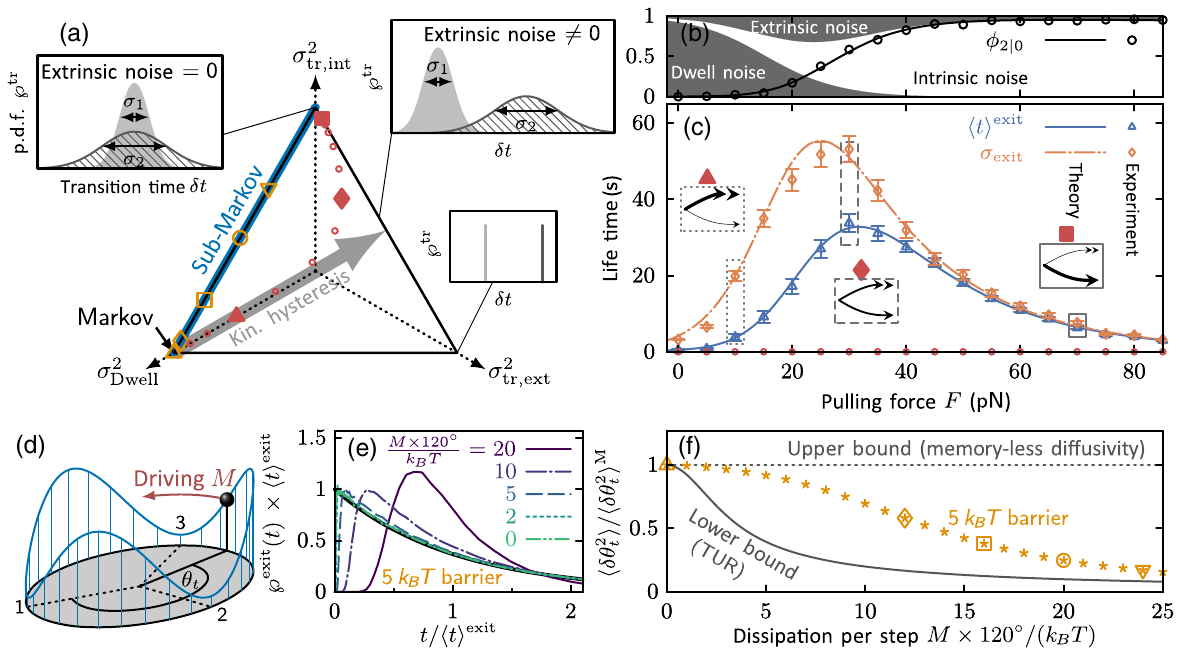
FIG. 7. Manifestations of transition noise and “ flavor of memory. ” (a) The partitioning of noise contributions mapped onto a triangle; = 3 . The left corner corresponds to the center of the triangle represents the equipartitioning of noise sources σ 2 ¼ σ 2 ¼ σ 2 tr ; ext ¼ σ 2 dwell tr ; int exit σ 2 Markov kinetics σ 2 ¼ 0 , and the left edge (blue line) to “ sub-Markov ” kinetics σ 2 tr ; ext ¼ 0 . The top corner corresponds to a tr ; ext ¼ tr ; int vanishing dwell and extrinsic transition noise σ 2 ¼ σ 2 tr ; ext ¼ 0 , whereas the right corner depicts the limit of vanishing dwell and dwell intrinsic transition noise σ 2 ¼ σ 2 ¼ 0 . The boxed probability density functions (p.d.f. ℘ tr ) are shown for illustrative purposes. The dwell tr ; int kinetic hysteresis increases along the gray arrow. The red circles depict the results of the catch-bond example for different pulling forces F shown in panels (b) and (c) [results depicted by larger symbols are additionally illustrated in (c)], and orange symbols show the results for the driven ATPase shown in panel (f). (b),(c) Reconstructed catch-bond experiment. (b) shows ϕ 2 , the probability of taking the slow j 0 = σ 2 = σ 2 = σ 2 pathway 2 (black line); the shaded areas depict the fraction of dwell ( σ 2 ), extrinsic ( σ 2 ), and intrinsic ( σ 2 ) noise, tr ; ext dwell exit exit tr ; int exit respectively. (c) depicts the mean h t i exit and standard deviation σ of the bond ’ s lifetime. Lines correspond to exact results, and exit symbols are deduced from 500 rupture experiments. Red circles depict pulling forces considered in panel (a). The density of the lifetime of the bond at F ¼ 20 pN is shown in Fig. 1(d). (d) – (f) Driven molecular motor displaying a vanishing extrinsic transition noise σ 0 . (d) Free-energy landscape as a function of the angle θ T (blue line; see Appendix E 3 for details) with a barrier height of 5 k t B tr ; ext ¼ that becomes tilted due the action of the torque M (red arrow); dotted lines denote network states, i.e., free-energy minima. (e) Scaled probability density of exit time from a state (i.e., first-passage time to an angular displacement of (cid:5) 2 π = 3 ¼ (cid:5) 120 °) as a function of the T . (f) Steady-state mean- dissipation per step (i.e., torque M multiplied by the rotation step 120°) of magnitude 0,2,5,10, and 20 k B M as a function of the dissipation. The full line squared angular deviation h δθ 2 compared with the a Markov-jump approximation h δθ 2 t i t i depicts the lower bound (E7) derived in Appendix (E4) using the thermodynamic uncertainty relation (TUR) [79,80]; the individual noise contributions for selected points (open symbols) are shown in panel (a). Parameters: (b),(c) see Appendix E 2; (d) – (f)